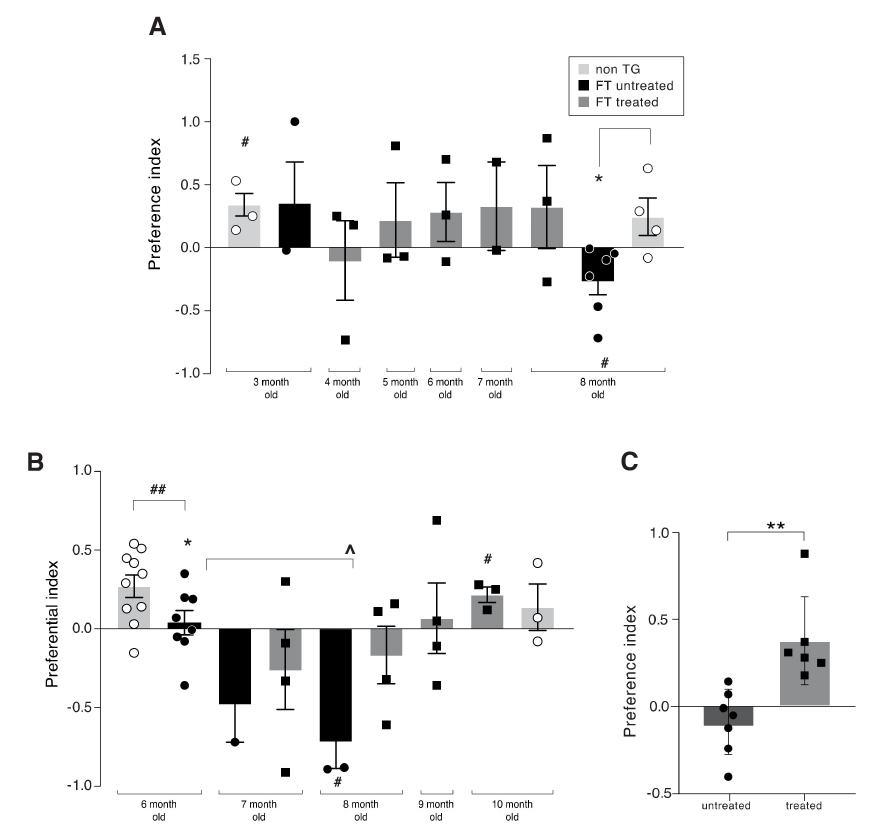
Figure 4. In vivo, monthly behavior follow-up of 5xFADXTau (FT) mice treated with a mixture of APP1 and Tau1 peptides versus control PBS treated mice. ( A ) “Novel” arm di ff erential preference index among control (non-transgenic) and transgenic FT mice, treated and non-treated (PBS treated), between the age of three to eight months. At the age of three months, only non-Tg control mice exhibited a significant preference to the “Novel” arm ((# p = 0.016). The benefits of the treatment were evident at the end of the five months course. At the age of eight months, only non-treated FT mice exhibited significant poor Y-maze performance (# p = 0.035) and di ff ered significantly from non-Tg control mice (* p =